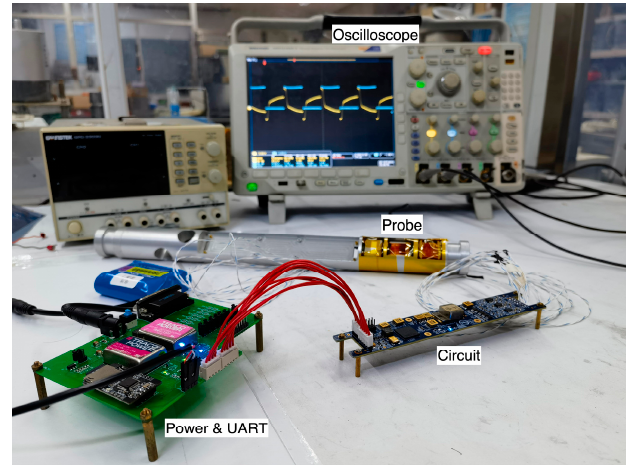
Figure 10. Excitation circuit waveform measurement experiment.